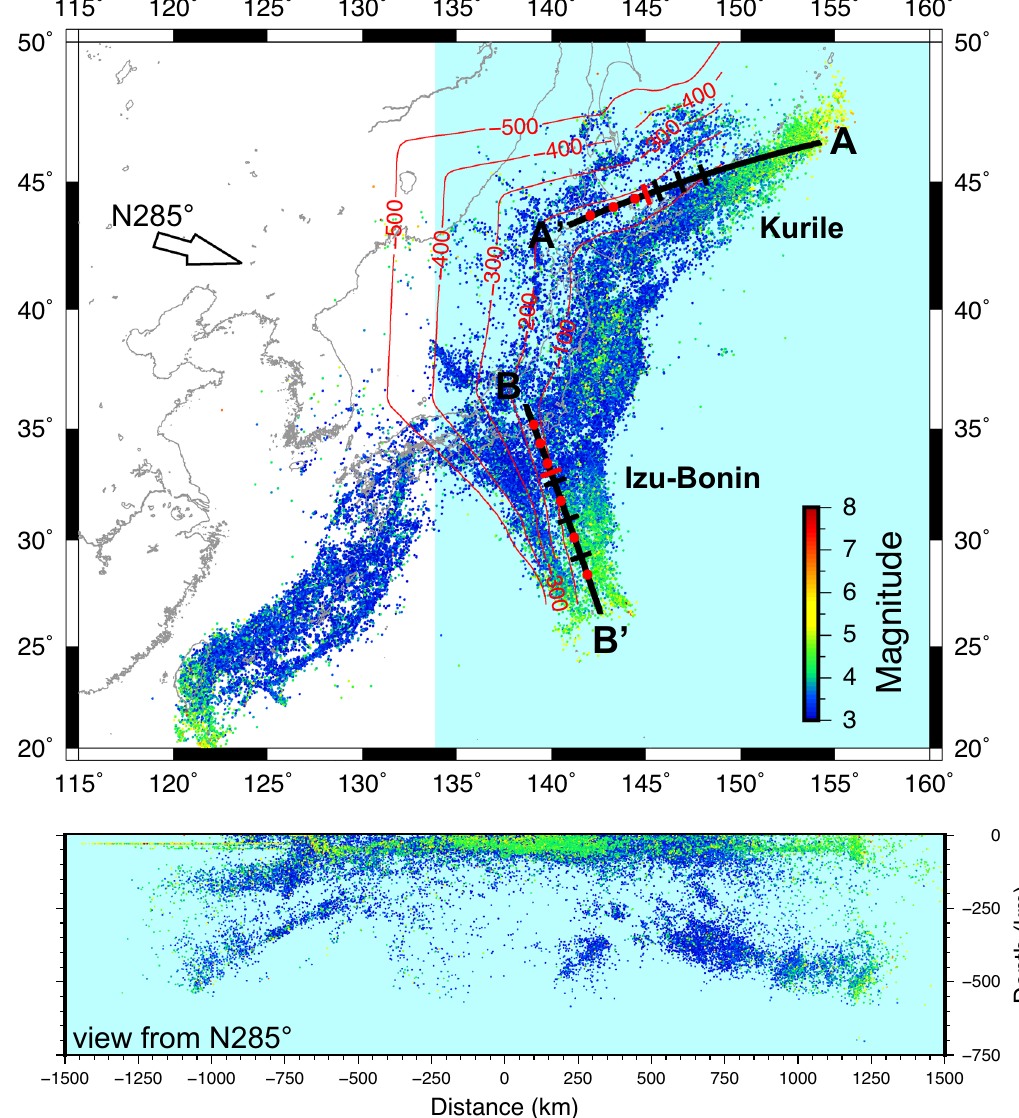
Figure 1. Map of the earthquakes in the northwestern Pacific subduction zone. Only events with M ≥ 3.0 are displayed, which are better located and more representative of the stress state in the slab. The labeled red lines depict depth contours of the upper boundary of the subducting slab as estimated from earthquakes’ location 52 . The seismic events in the light blue shaded box, as seen from N285° (arrow on the map), are reported in the vertical cross-section at the bottom. The black lines indicate the trace of the Kurile and Izu–Bonin vertical sections shown in Figs. 2 and 3, with red ticks marking the origin of the distance axis. The location of the profiles in Fig. 4 (black ticks) and in Supplementary Figs. S3 and S4 (red dots) is also